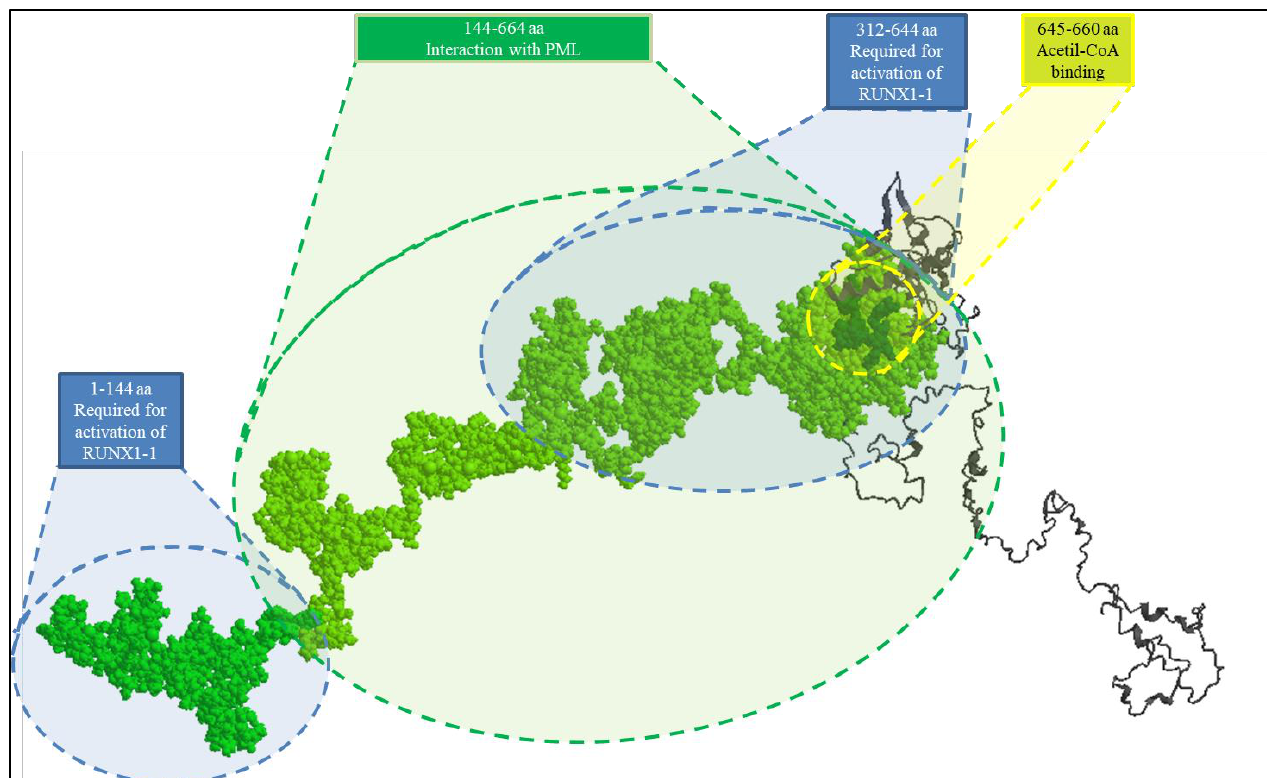
Figure 2. Three-dimensional structures of the 1129 amino acid (aa) KAT6A truncating protein. The PML interaction domain (aa 144–664) and the two RUNX1-2 domains (aa 1–144 and 312–644, respectively) are required for protein interaction and activation, which were highlighted in space- filling mode. The domain 645–660 aa of the acetyl-CoA binding site is marked with a yellow circle. The deletion of the C-terminal region may increase the availability of PML in the cytoplasm and the cellular distribution of RUNX2. The ability to recognize acetil-coA, on the other hand, stays unal- tered.